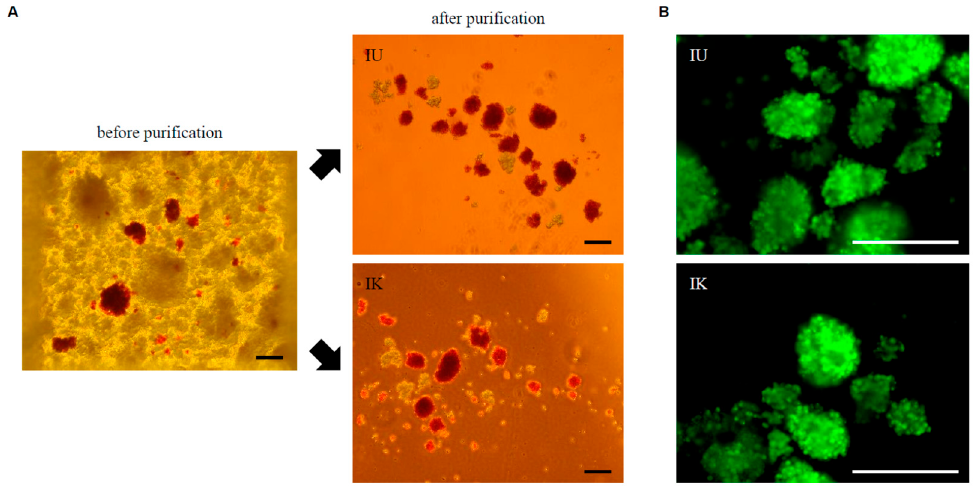
Figure 2. Dithizone (DTZ) and fluorescein diacetate / propidium iodide (FDA / PI) staining of islets. ( A ) DTZ staining before and after islet purification. ( B ) FDA / PI staining of isolated islets. Scale bars = 200 µ m. Table 4. Viability, purity, and score of islets after purification.